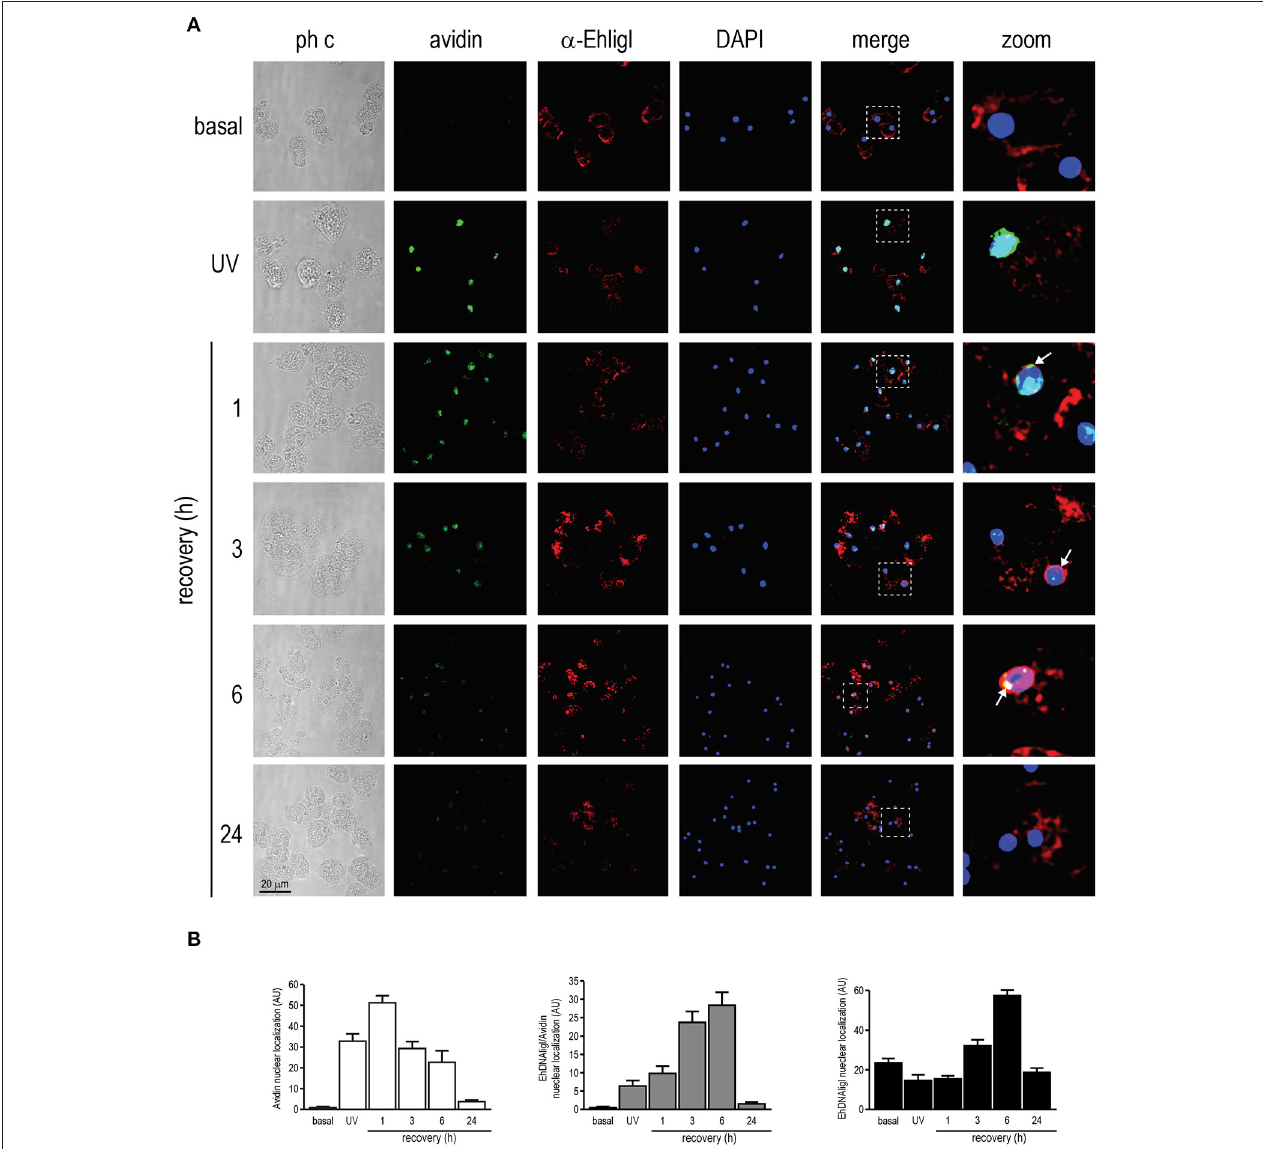
FIGURE 6 | Co-localization of EhDNAligI with the 8-oxoG adduct after UV treatment in E. histolytica trophozoites. (A) Immunofluorescence assays of trophozoites in basal condition, immediately or recovered at different times after treatment with UV (150 J/m 2 ). Trophozoites were incubated with avidin-FITC (Avidin) (green), and the α -EhDNAligI ( α -EhligI) antibody (red). Nuclei were counterstained with DAPI (blue). Merge: overlapping of fluorescent channels. Confocal microscopy images show a xy -section. ph c: Phase-contrast. Arrows: co-localization of EhDNAligI and avidin-FITC. Squares were magnified in right panels. (B) Quantification of green (Avidin), red (EhDNAligI) and green/red fluorescence channels using DAPI staining as reference for the cell number.